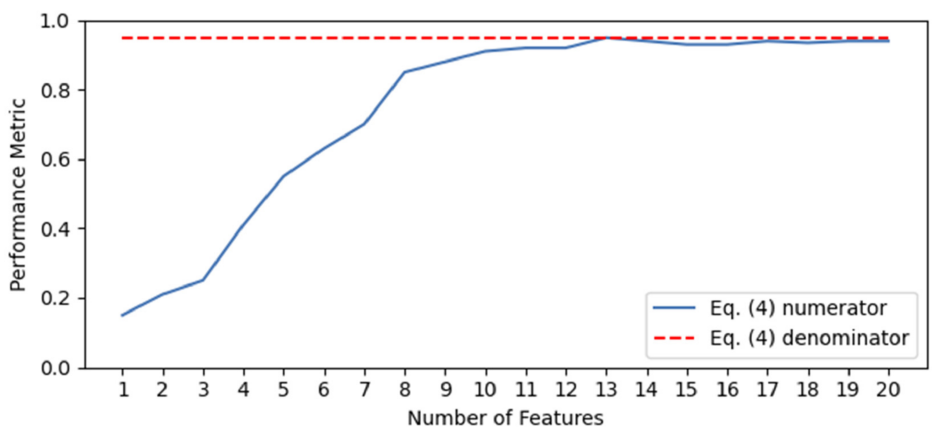
Figure 7. Graphical representation of Equation